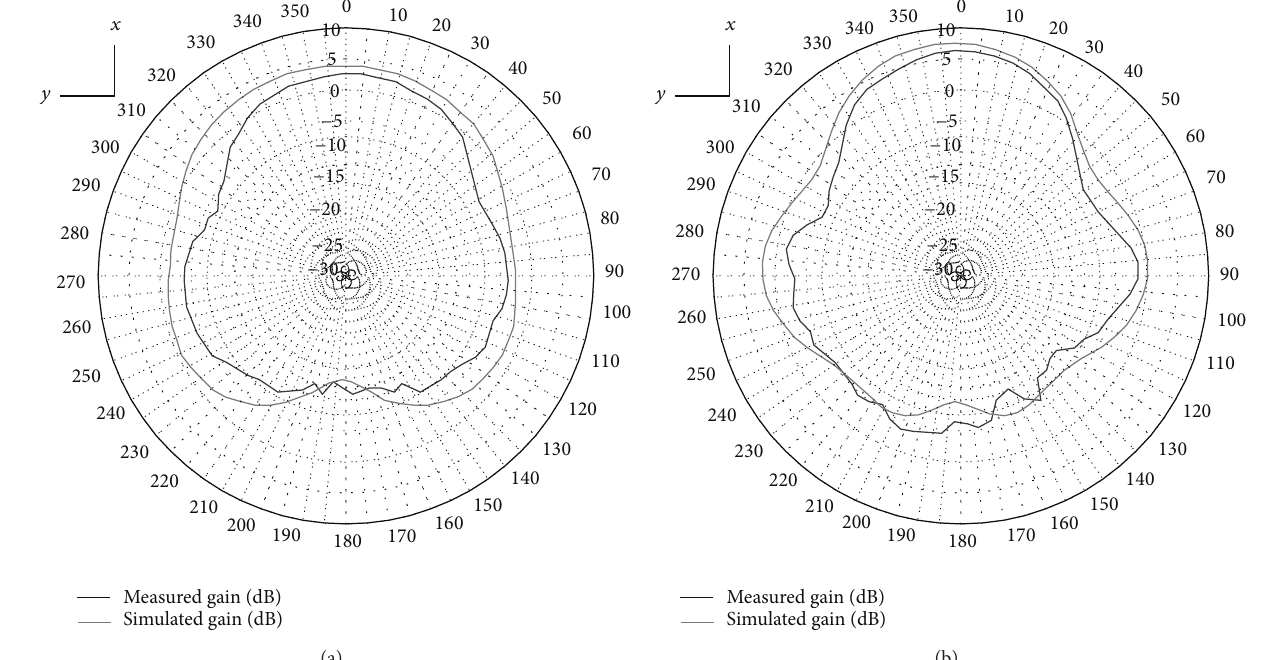
Figure 28: Measured and simulated radiation pattern at 5GHz (a) and 10GHz (b) of the second proposed planar directional UWB